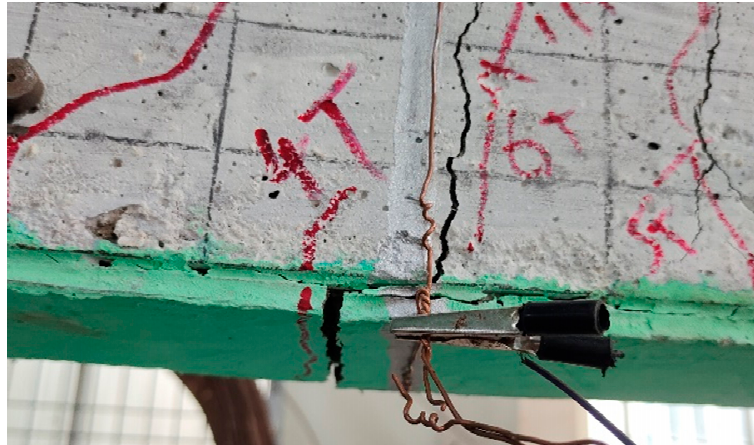
values. The pictorial representation of the crack formed on the smart mortar layer at the bottom of the beam is shown in Figure 7.